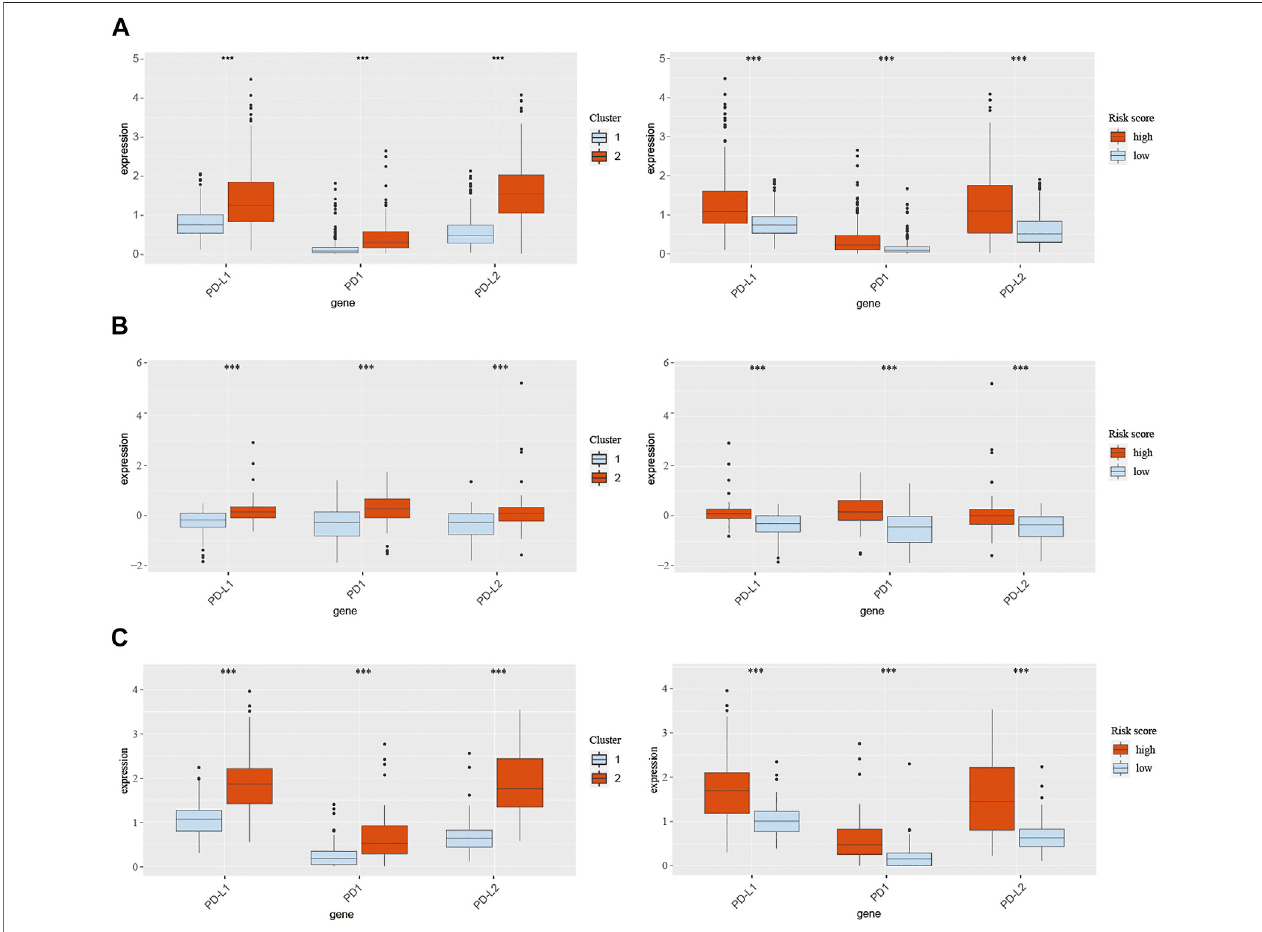
FIGURE 8| Expression of PD-1, PD-L1, and PD-L2 in different clusters and risk groups in training and validation cohorts. (A) Expression of PD-1, PD-L1, and PD- L2 incluster1,cluster2,thelow-riskgroup, andthehigh-risk groupfromTCGA database. (B) Expression ofPD-1, PD-L1,and PD-L2 incluster1,cluster2,thelow-risk group, and the high-risk group from the CGGA301 database. (C) Expression of PD-1, PD-L1, and PD-L2 in cluster 1, cluster 2, the low-risk group, and the high-risk group from the CGGA325 database. The Wilcox test was used to compare the difference between the two groups (*** p < 0.001).